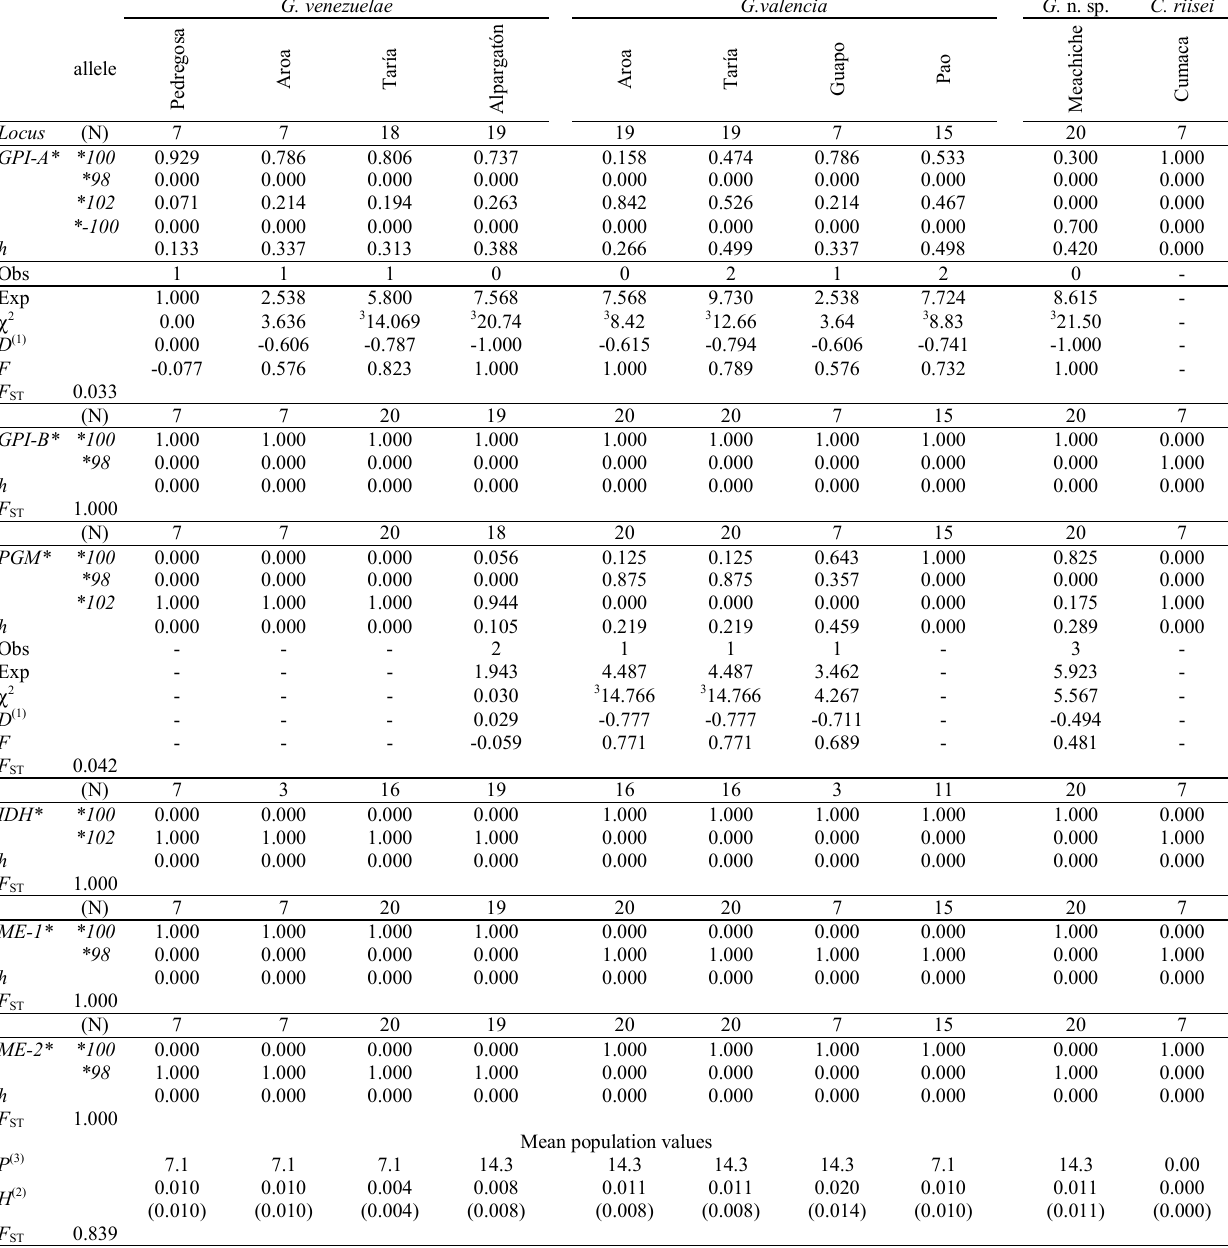
Table 2. Allelic frequencies, heterozygosity per locus ( h ; unbiased estimation according to Nei, 1978) for the polymorphic locus and the diagnostic loci in the Gephyrocharax and Corynopoma populations studied. (N) number of individuals studied, ( P ) percentage of polymorphism, ( H ) average heterozygosity (standard errors in parentheses), (Obs) heterozygotes observed, (Esp) heterozygotes expected, ( χ 2 ) chi squared, (D) heterozygote deficiency coefficient, (F) fixation index, (F population differentiation coefficient. (1) Negative values indicate heterozygote deficiency. (2) Direct-count. A locus is considered polymorphic if the frequency of the most common allele ( *100 ) is lower than 0.990. (3) significative with a 99%